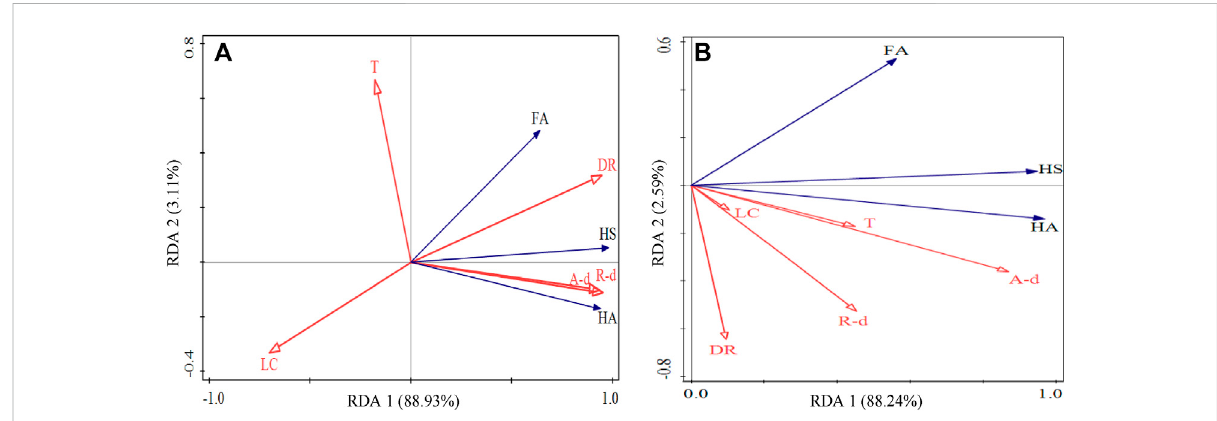
FIGURE 8 Redundancy analysis (RDA) of two composting methods: mixed material (A) and single material (B) . Red and black arrows represent environmental and humic acid parameters, respectively. Note: T: temperature; LC: lignin content; DR: the cumulative degradation rate of organic materials; A-d: absolute degradation of lignin; R-d: the relative amount of lignin degradation; HS, humus; FA, fulvic acid; HA, humic